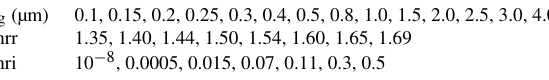
Table 5. Parameters used for the calculations of the optical properties of smoke particles, using the non-spherical model of AERONET, in Figs. 12 and